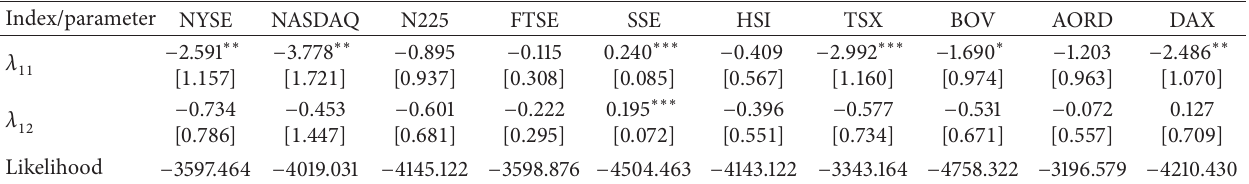
Table 10: Results of TVRAS-GARCH-M model ( 𝑃 5 𝑡 ).